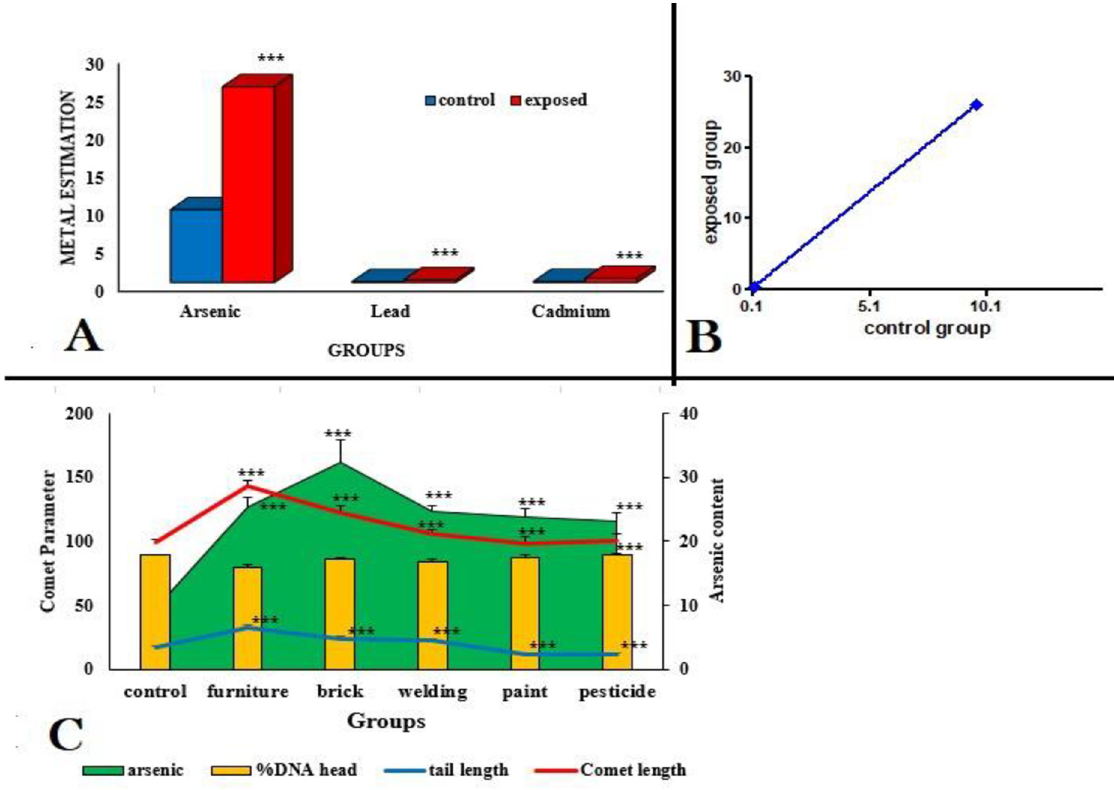
Fig 6. Deposition of metal content (arsenic, lead, cadmium) in blood samples of occupationally exposed workers of different industries (A). Calculated regression line showing metal deposition in control and exposed workers ((b = 2.718 ± 0.01367; F (1,2) = 39521; P = 0.0032) (B). Association of arsenic content with different parameters of comet assay (C). ��� P < 0.001.